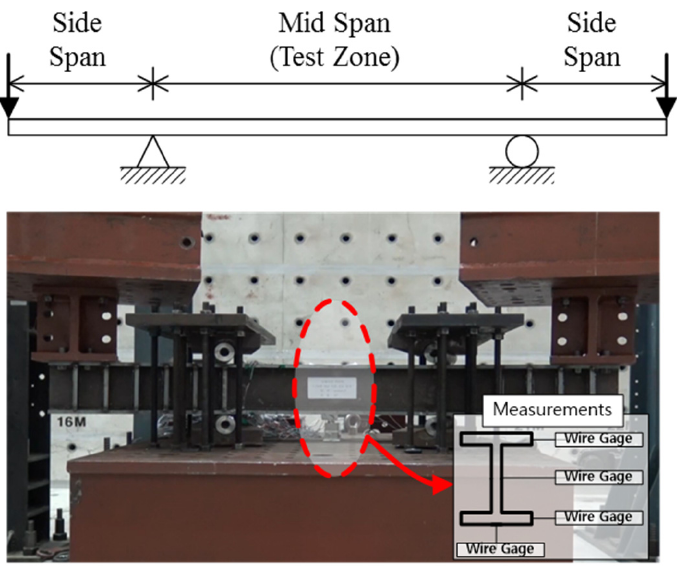
Figure 12. Test Setup/Displacement Measurements.